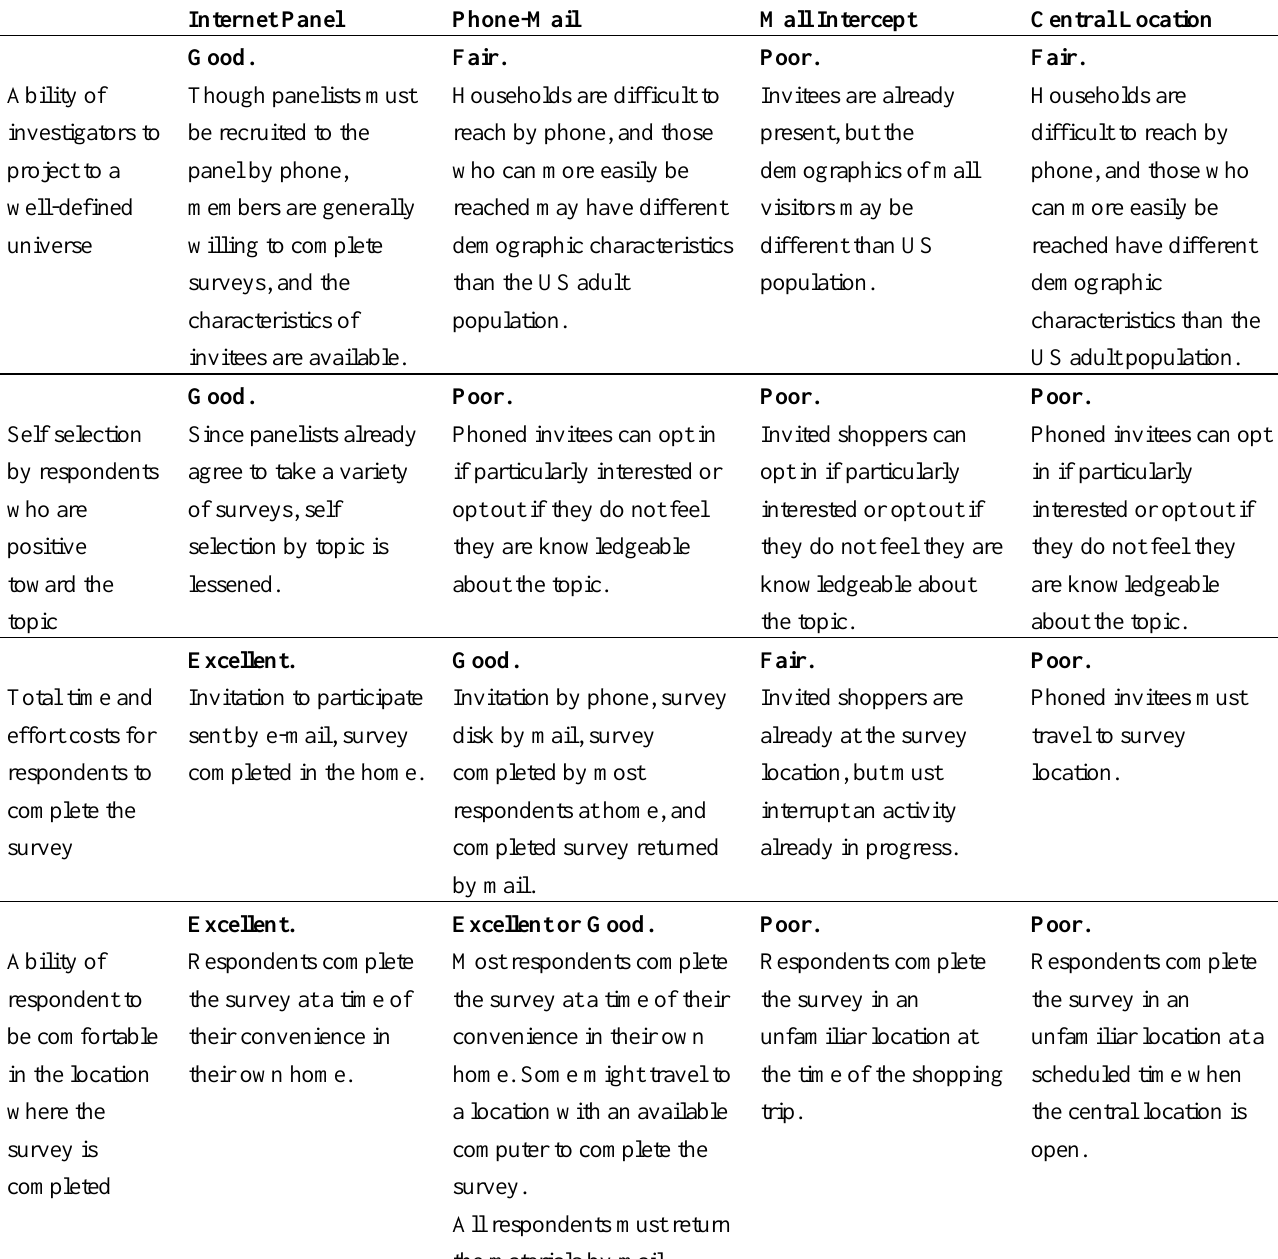
Table 9. Participation factors and the performance among survey modes. Internet